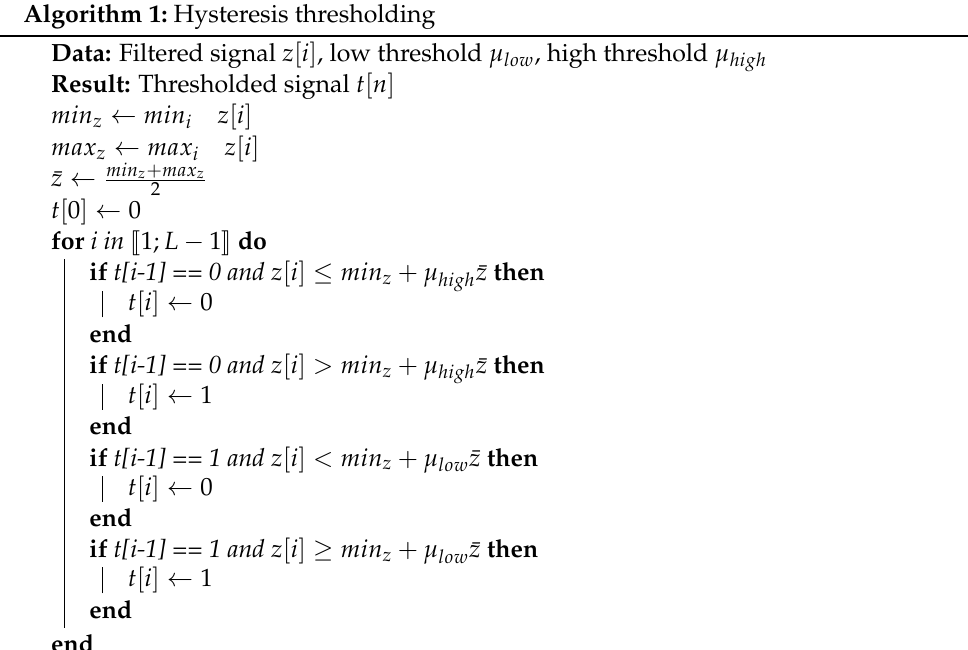
Algorithm 1: Hysteresis